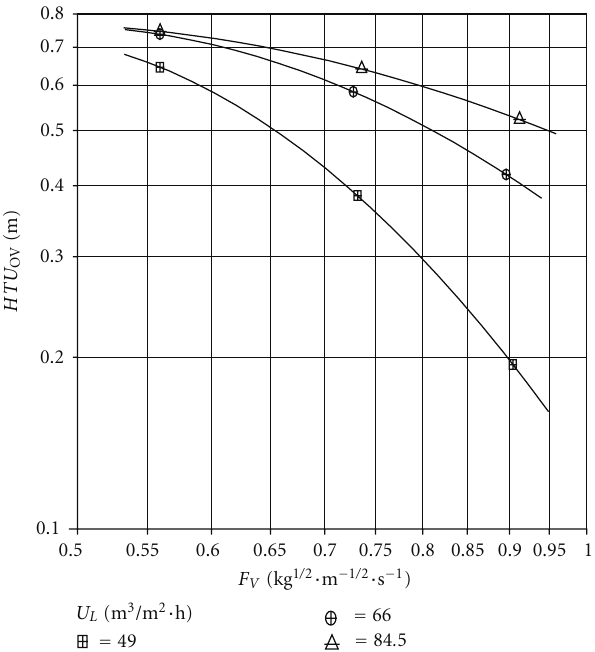
Figure 5: Global height mass transfer unit versus the gas capacity